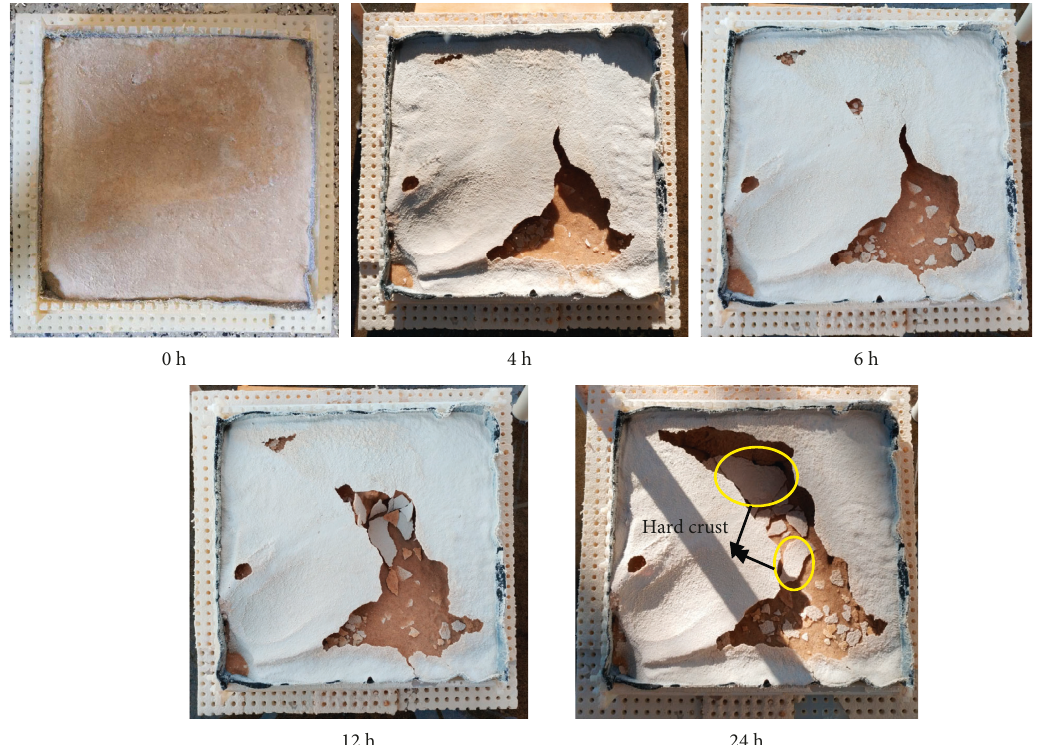
Figure 7: Photograph of 0.25M Ca MICP-treated soil after 105mm/h rainfall-induced erosion under different eroded